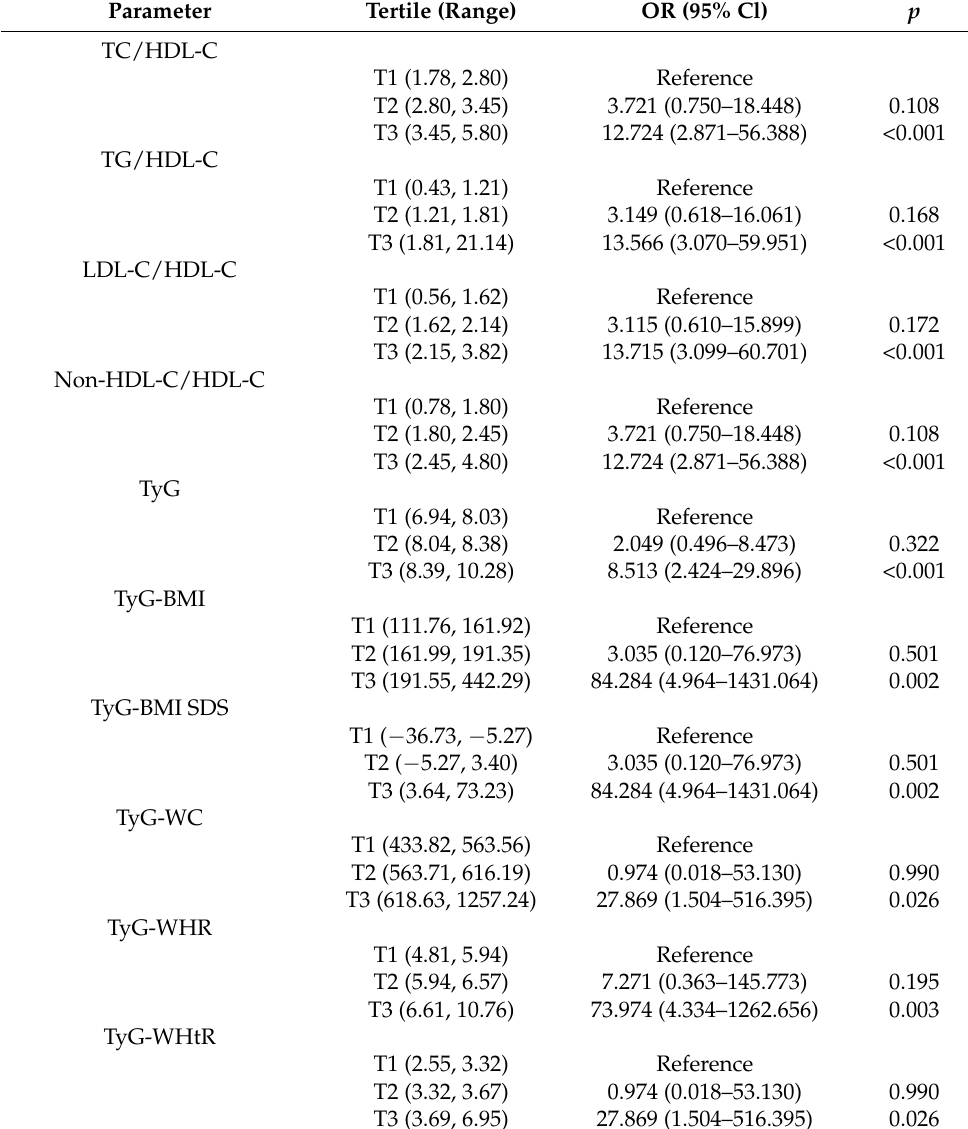
Table 2. Odds ratios for NAFLD according to tertiles of each